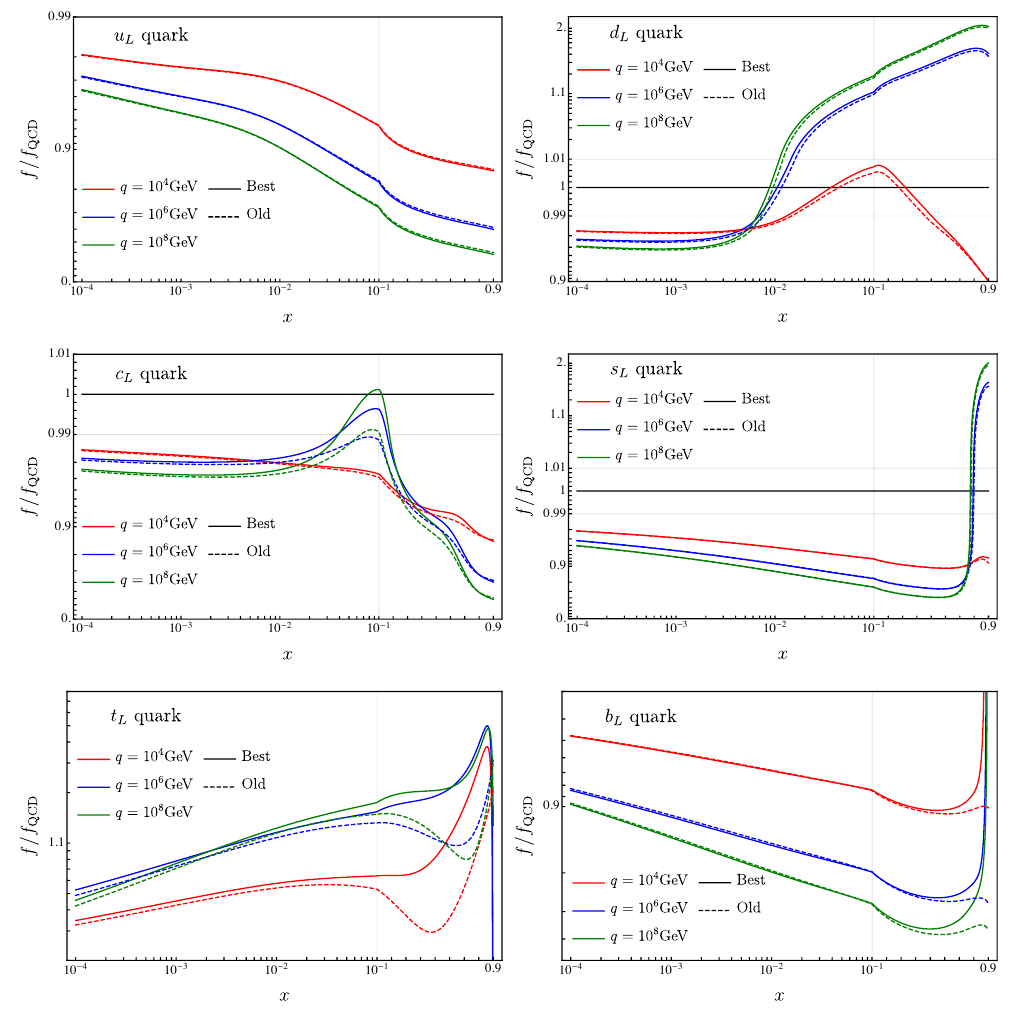
Figure 3 . Left-handed quark PDFs in the full unbroken SM, divided by their values assuming pure QCD evolution only. The thin gray lines show where the scales on the x- and/or y-axes switch between linear and